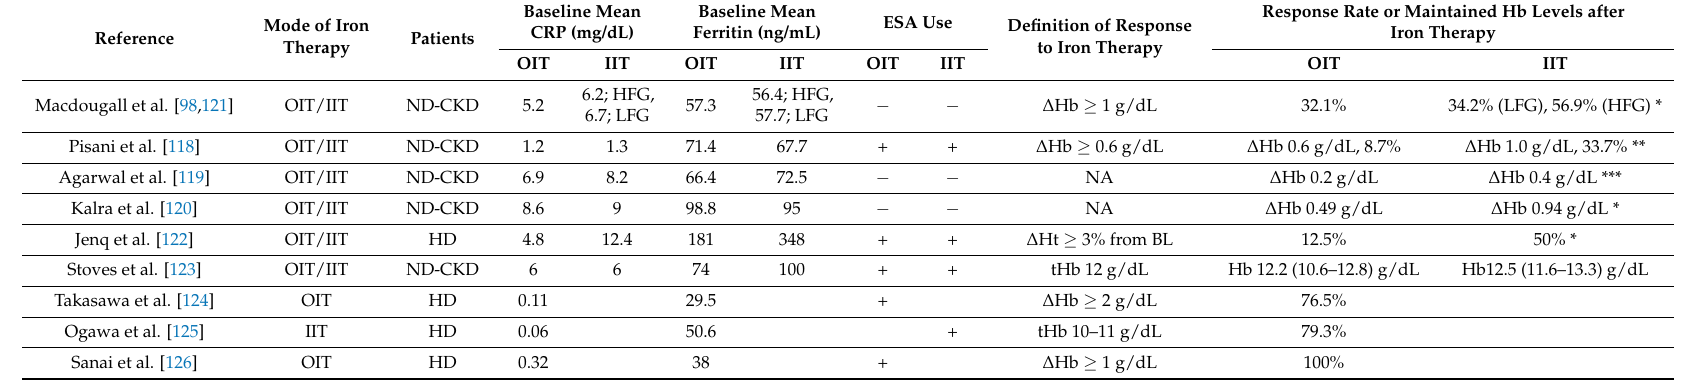
BL: baseline, CKD: chronic kidney disease, CRP: C-reactive protein, ESA: erythropoiesis-stimulating agents, Hb: hemoglobin, HD: hemodialysis, Ht: hematocrit, IIT: intravenous iron therapy, ND: non-dialysis, OIT: oral iron therapy, tHb: target Hb. NA: not available. ∆ Hb and Ht are defined as the change in Hb and Ht before and after iron supplementation. HFG = high